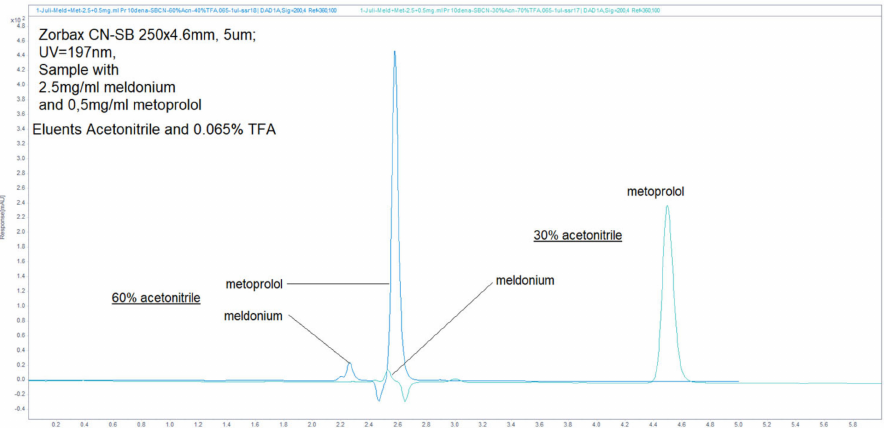
Figure 47. Two chromatograms with Zorbax CN-SB column of sample with doubled percentage of CAN in eluent. TFA enables enormous an approach of peak of metoprolol to meldonium, reducing their resolution to very low values approaching to